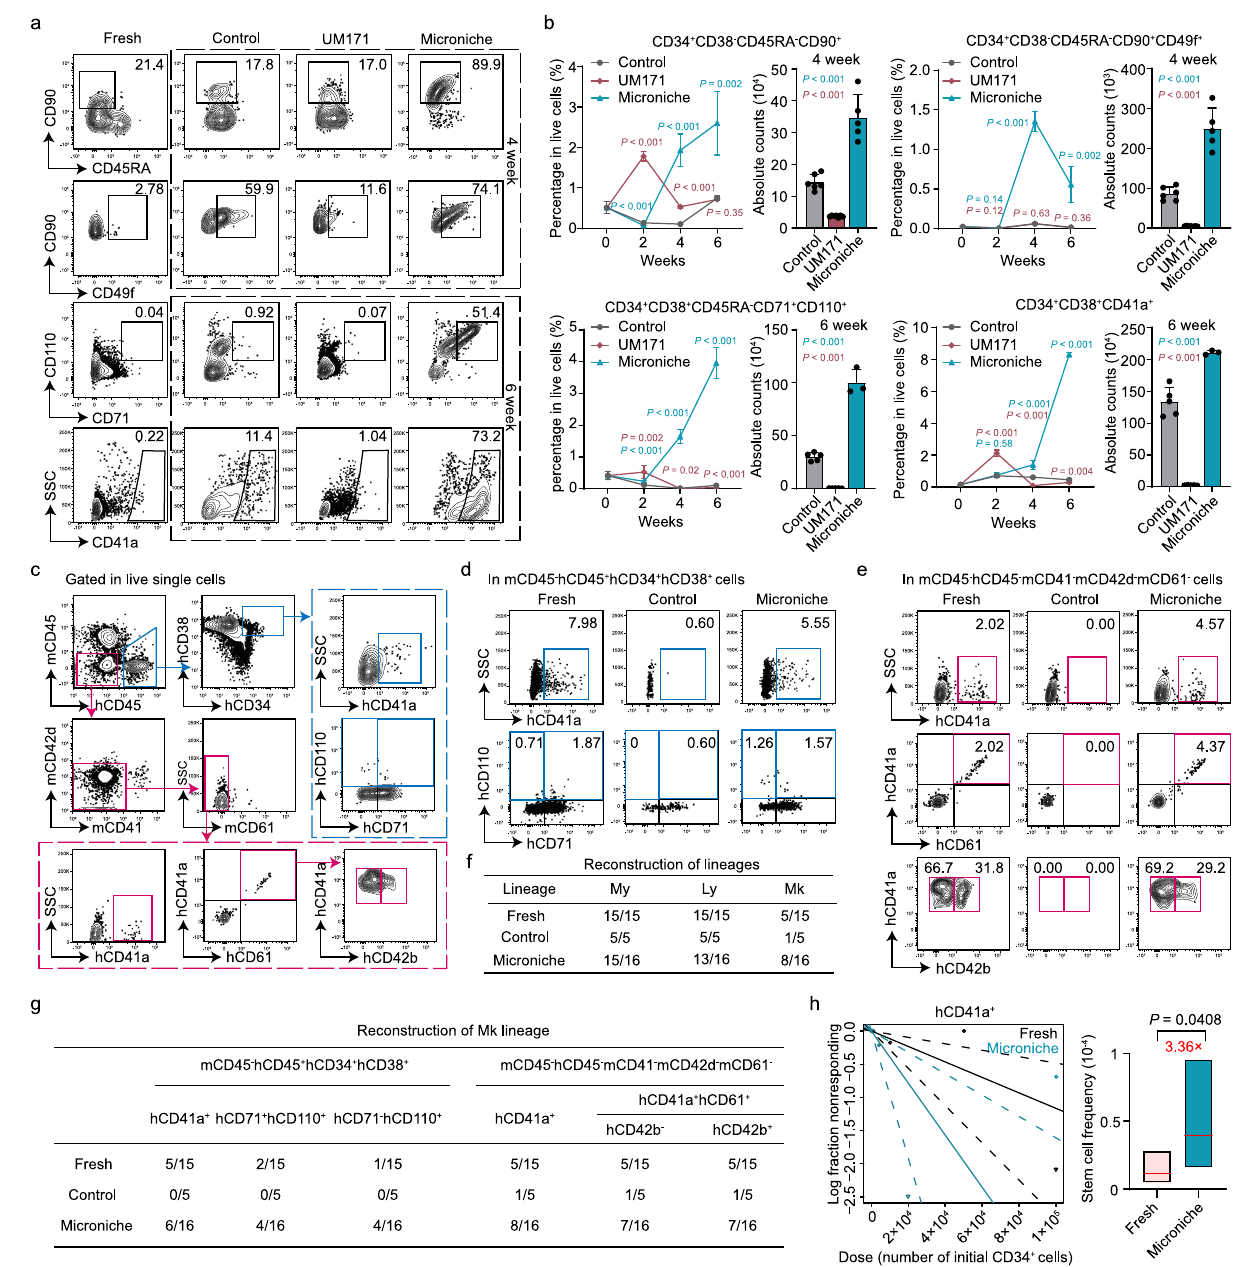
− mCD61 − ( e ) cells of NOG mice at 16 weeks post-transplantation. f The pro- portions of successfully reconstituted myeloid (My; mCD45 − hCD45 + hCD33 + ), lymphoid (Ly; mCD45 − hCD45 + hCD19 + ), and megakaryocytic (Mk; mCD45 − hCD45 − mCD41 − mCD42d − mCD61 − hCD41a + ) lineages in hCD45 + engraf- ted mouse recipients. g The proportion of engrafted NOG mice with suc- cessful Mk lineage reconstruction based on the Mk population presence in BM mCD45 − hCD45 + hCD34 + hCD38 + or mCD45 − hCD45 − mCD41 − mCD42d − mCD61 − cell populations. h Mk-HSC frequency based on the mCD45 − hCD45 − mCD41 − mCD42d − mCD61 − hCD41a + subpopulation 16 weeks post-transplantation. Fresh n = 43, Control n = 30, Microniche n = 36 biologi- cally independent animals. Chi-square test. Solid lines indicate best- fi t linear model and dashed lines con fi dence intervals. Box plots show the median (middle line) with the 25th and 75th percentiles (box).